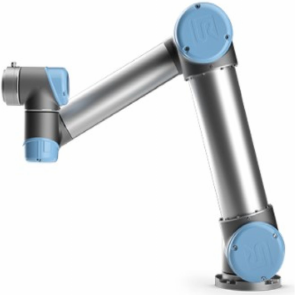
Figure 2. Physical simulation model of the UR5